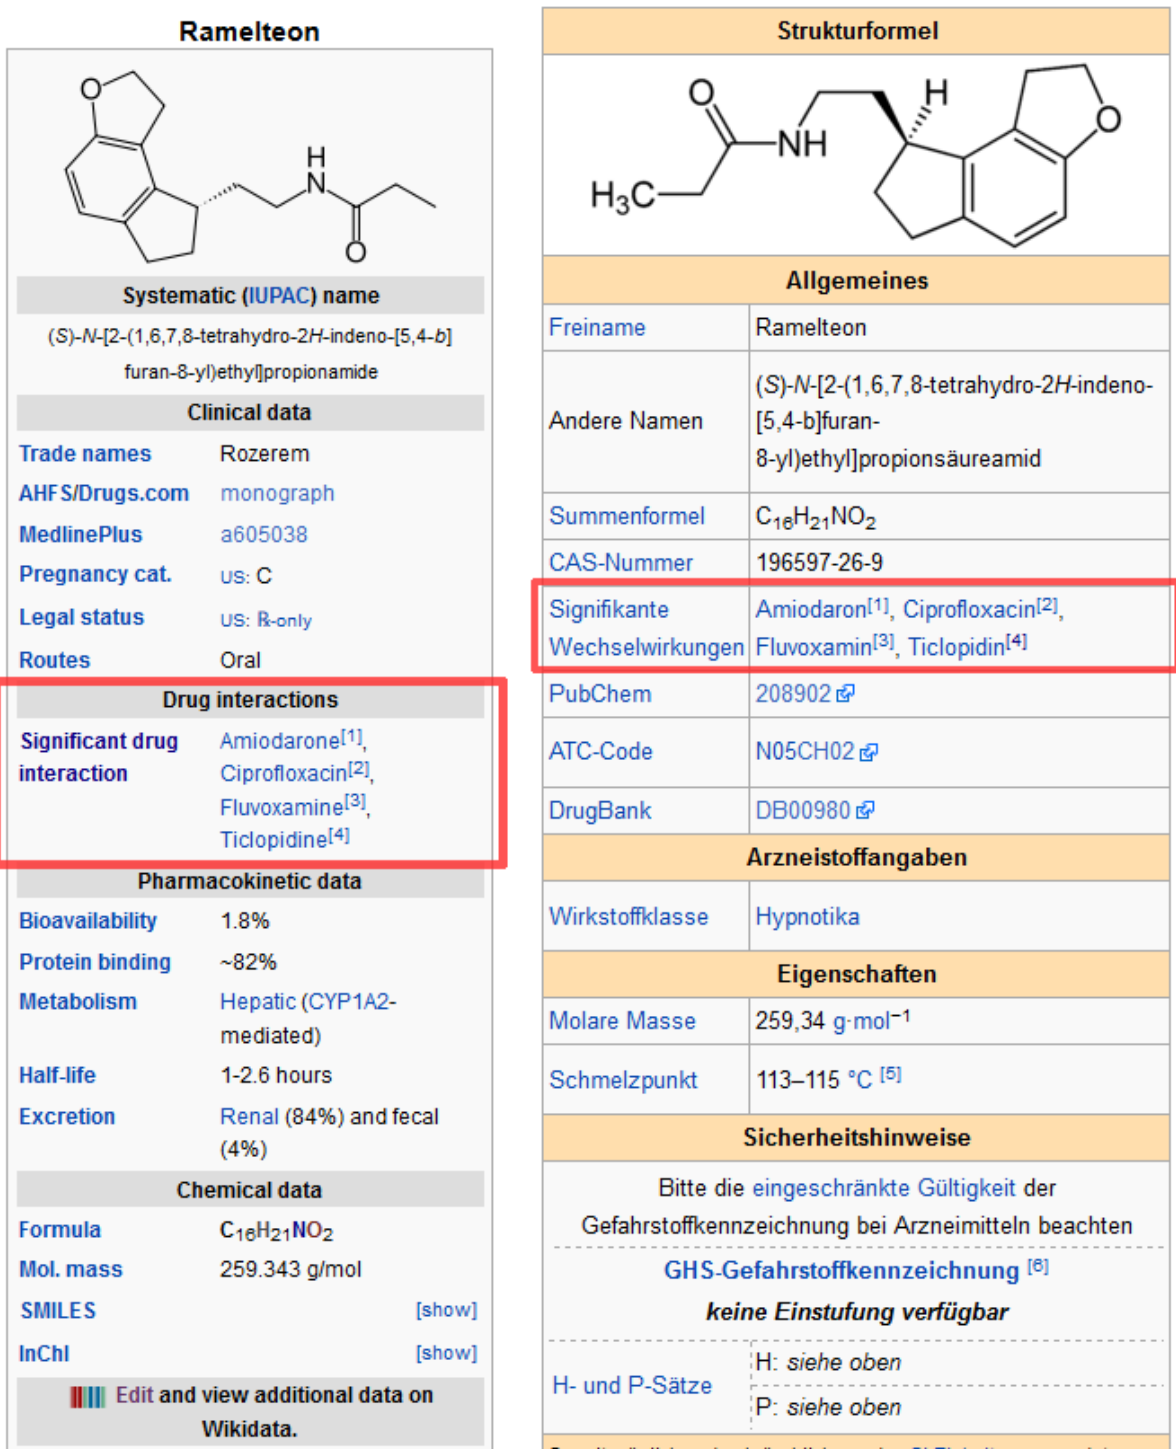
Figure 3. Screenshots of the English and German infoboxes of the pharmaceutical ramelteon. Drug interaction data automatically queried from the Wikidata knowledge base is